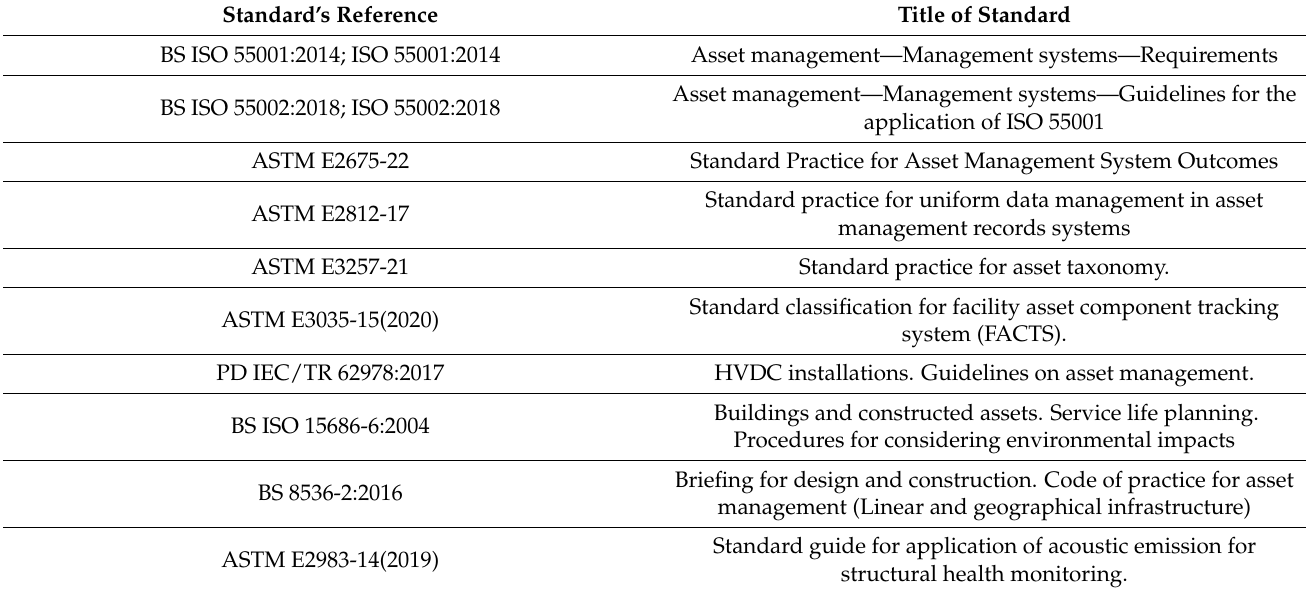
Table 6. Standards related to asset management, integrity, reliability and